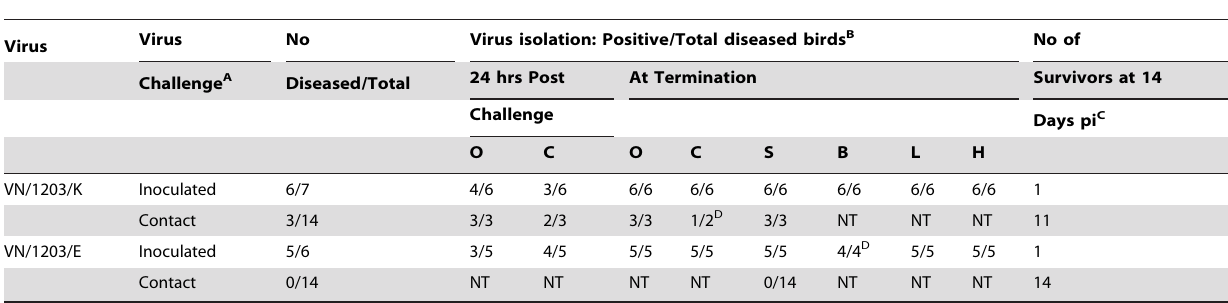
Table 1. Experimental infection of chickens by inoculation or contact challenge with HP VN/1203/K and HP VN/1203/E.